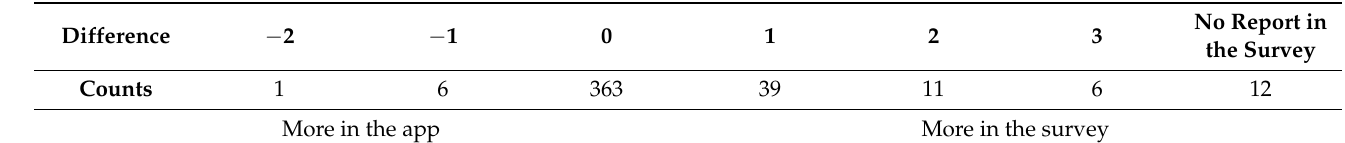
Table 3. Differences between the number of registered children per family in the app and reported in the survey.